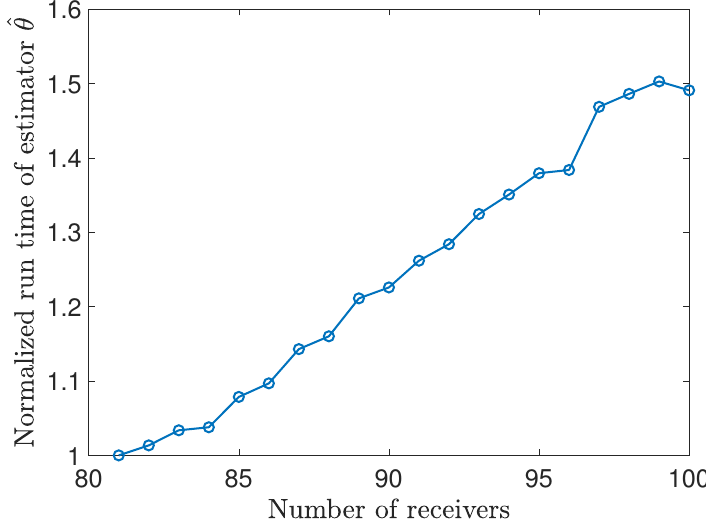
Figure 9. Normalized running time for locating multiple disjoint